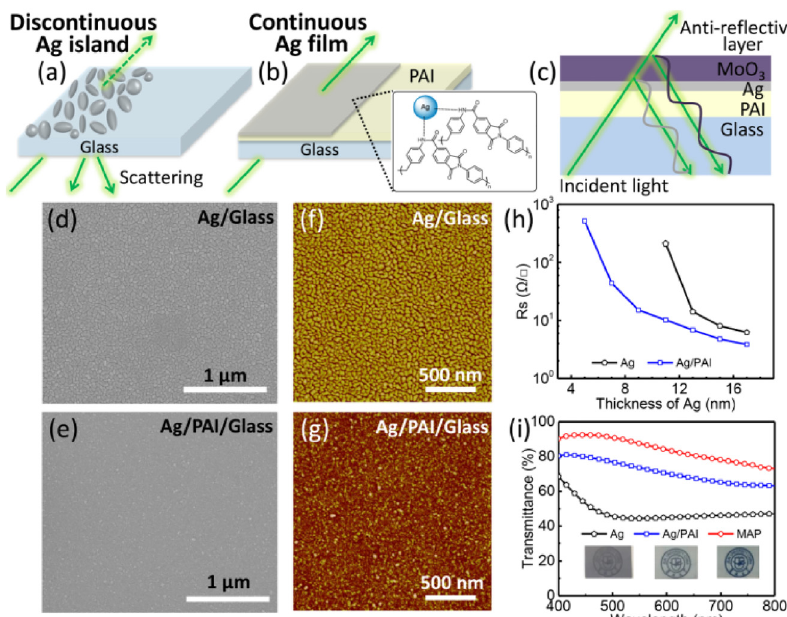
Figure 1: (a) – (b) Schematic illustration of the ultrathin Ag film without and with a polyamide-imide (PAI) layer on glass sub- strates. Inset of b: Coordination bond be- tween PAI and evaporated Ag. (c) Conceptual diagram of the incident light phase shift in the Ag film with the anti- reflective layer of MoO 3 . (d) – (g) Surface morphologyimagesoftheAg/glassandAg/ PAI/glass taken using scanning electron microscopy (SEM) and atomic force micro- scopy (AFM), respectively. (h) Evolution in sheet resistance of the Ag, Ag/PAI elec- trodes with different Ag thickness. (i) Opti- cal transmittance and corresponding photographs of the Ag, Ag/PAI and metal oxide/ultrathin Ag/polymer (MAP) elec-